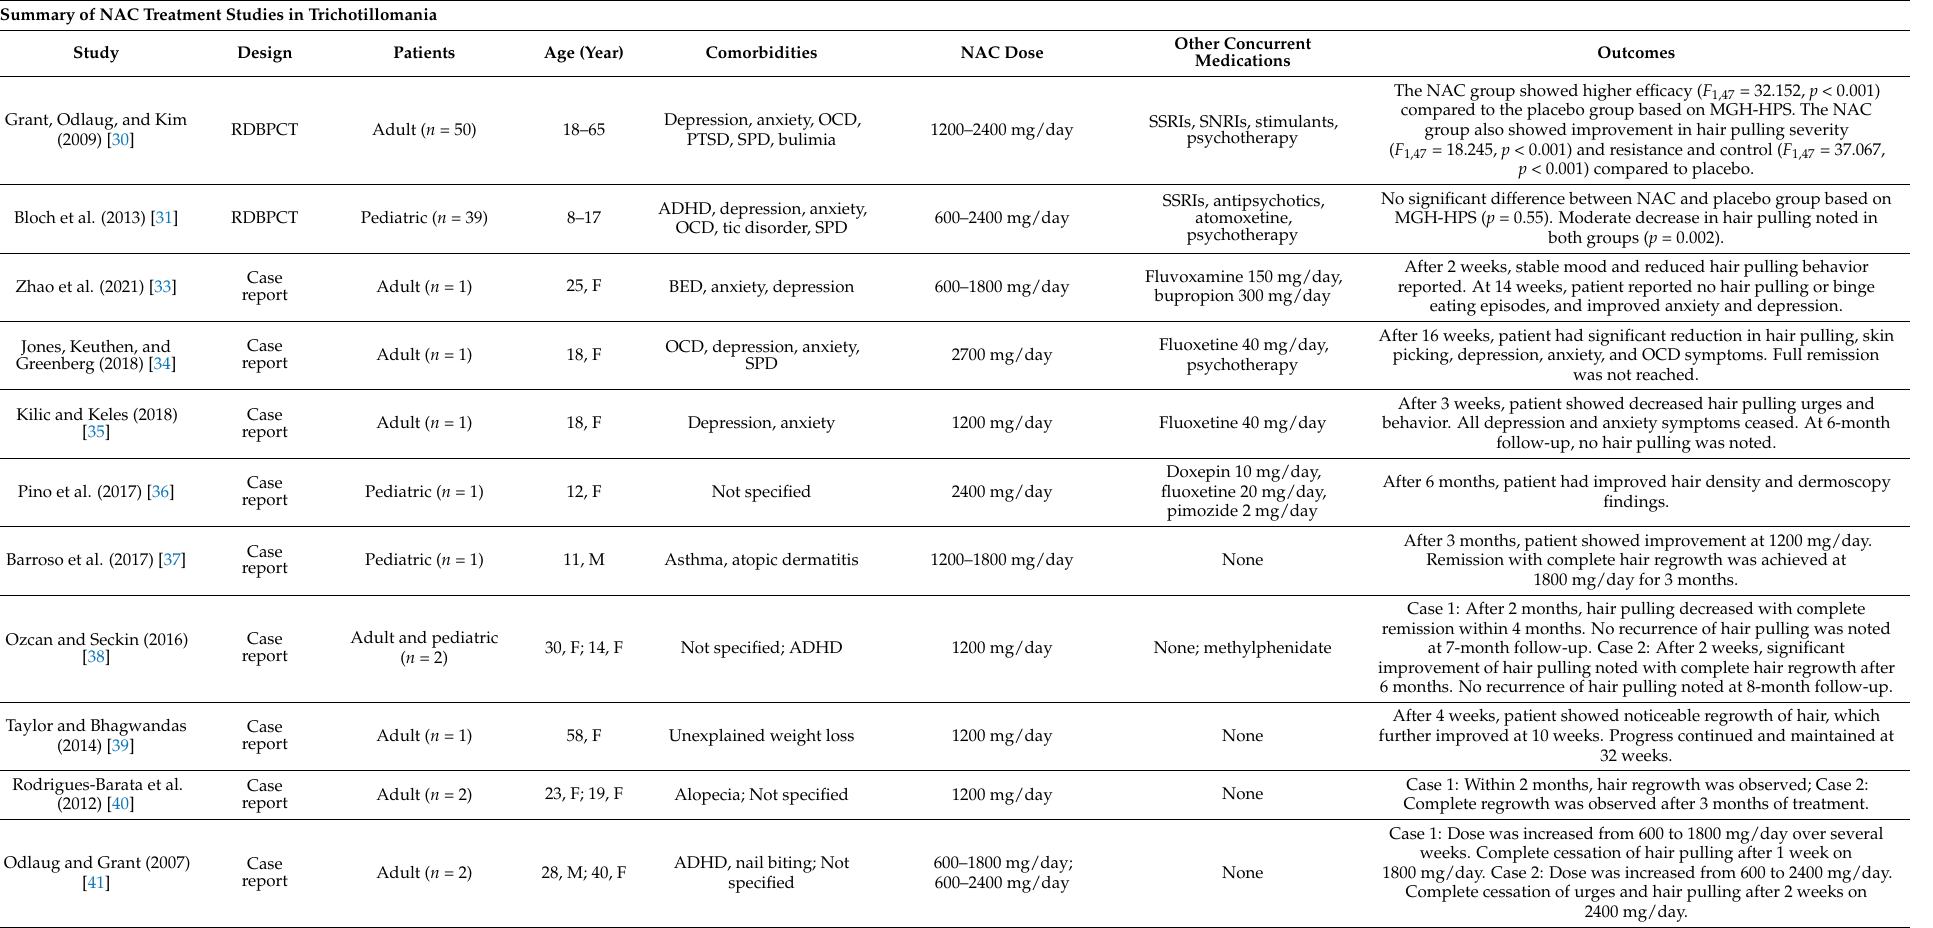
Table 1. Summarizes all NAC treatment studies for TTM, which includes one adult and one pediatric randomized double-blind controlled trials and nine case